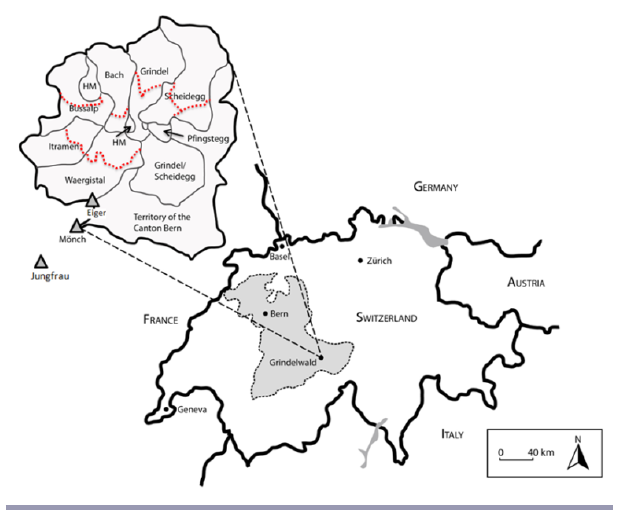
Fig. 1 . The seven corporations of Grindelwald. Adapted from Tiefenbach and Mordasini (2006). HM = Holzmatten corporation, with common property separated from the private property in the valley. The red dotted line marks the border between common property pastures (alp) and private property in the